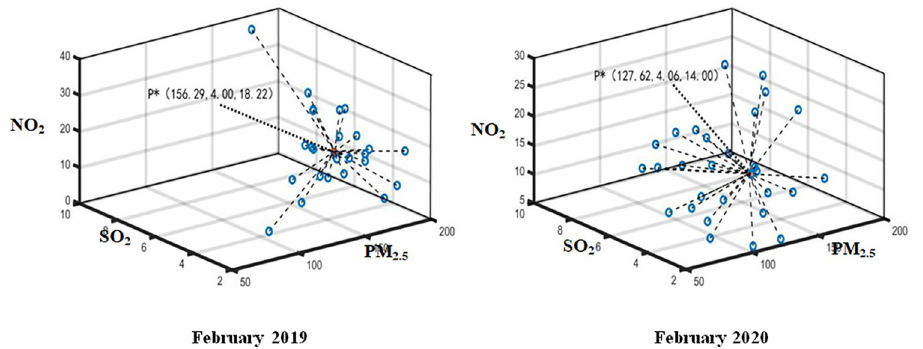
Fig 5. Aggregation result in February 2019 and 2020.